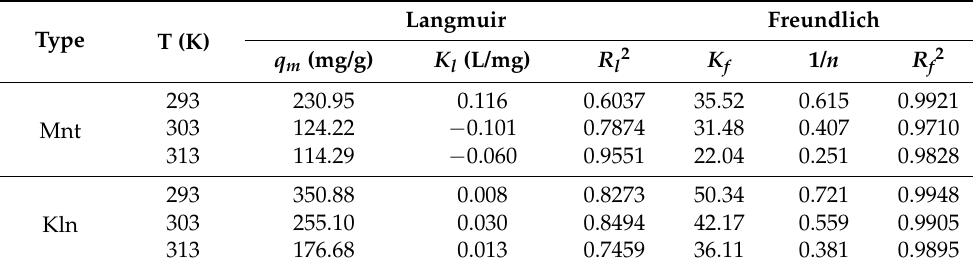
Table 1. Isothermal model of saturates adsorption on clay surfaces derived from Langmuir and Freundlich model.